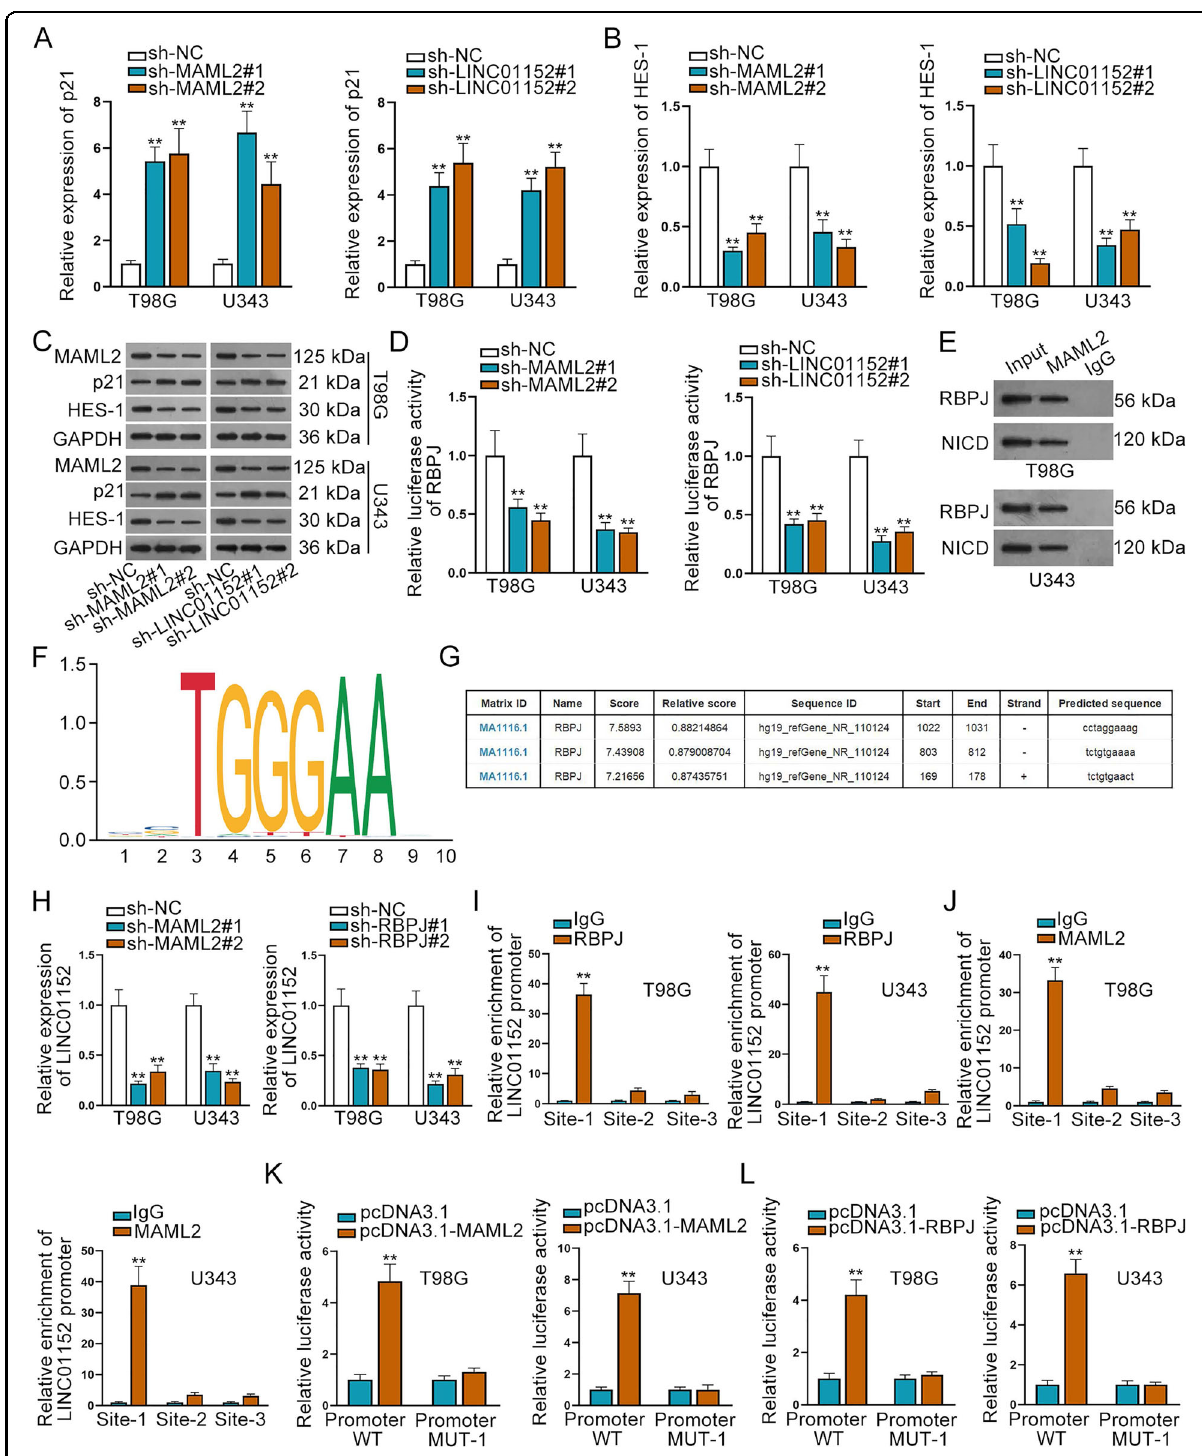
Fig. 6 MAML2 could activate LINC01152 expression via modulating Notch pathway in GBM cells. A – C Expression of p21 and HES-1 was tested via qRT-PCR and western blot when MAML2 or LINC01152 was silenced in T98G and U343 cells. D Luciferase activity of RBPJ was detected via luciferase reporter assay in T98G and U343 cells when MAML2 or LINC01152 was silenced. E CoIP assay searched the binding of MAML2 to RBPJ and NICD. F , G JASPAR (http://jaspar.genereg.net/) database was used to search the DNA motif of RBPJ and possible binding sites between RBPJ and LINC01152 promoter. H qRT-PCR probed the expression of LINC01152 when MAML2 and RBPJ were silenced. I , J The binding of RBPJ and MAML2 to LINC01152 promoter was veri fi ed via ChIP assay in T98G and U343 cells. K , L Luciferase activity of LINC01152 promoter (wild-type or mutant) was tested via luciferase reporter assay when RBPJ or MAML2 was overexpressed. ** P <